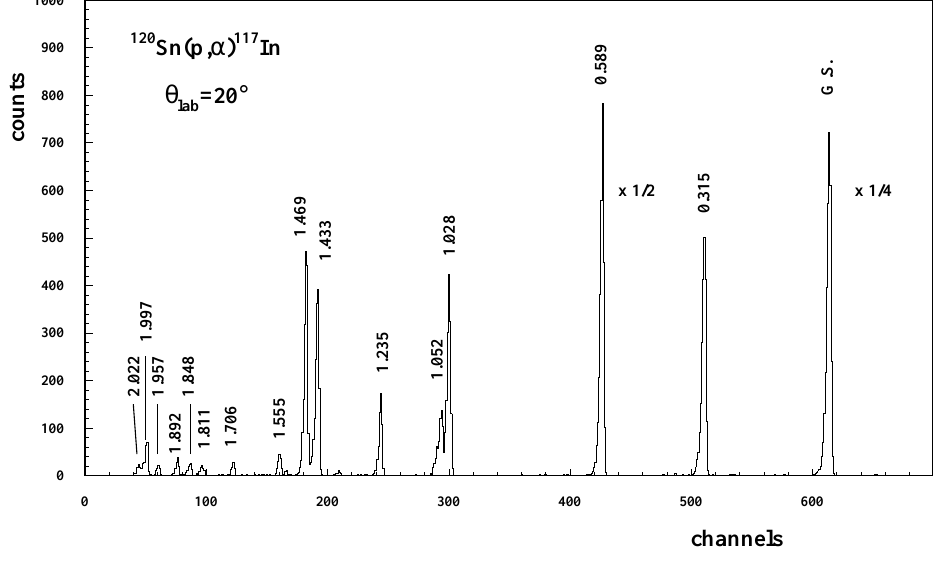
Fig. 1. Energy spectrum of α particles measured at 20 o for the 120 Sn( p ,α ) 117 In.